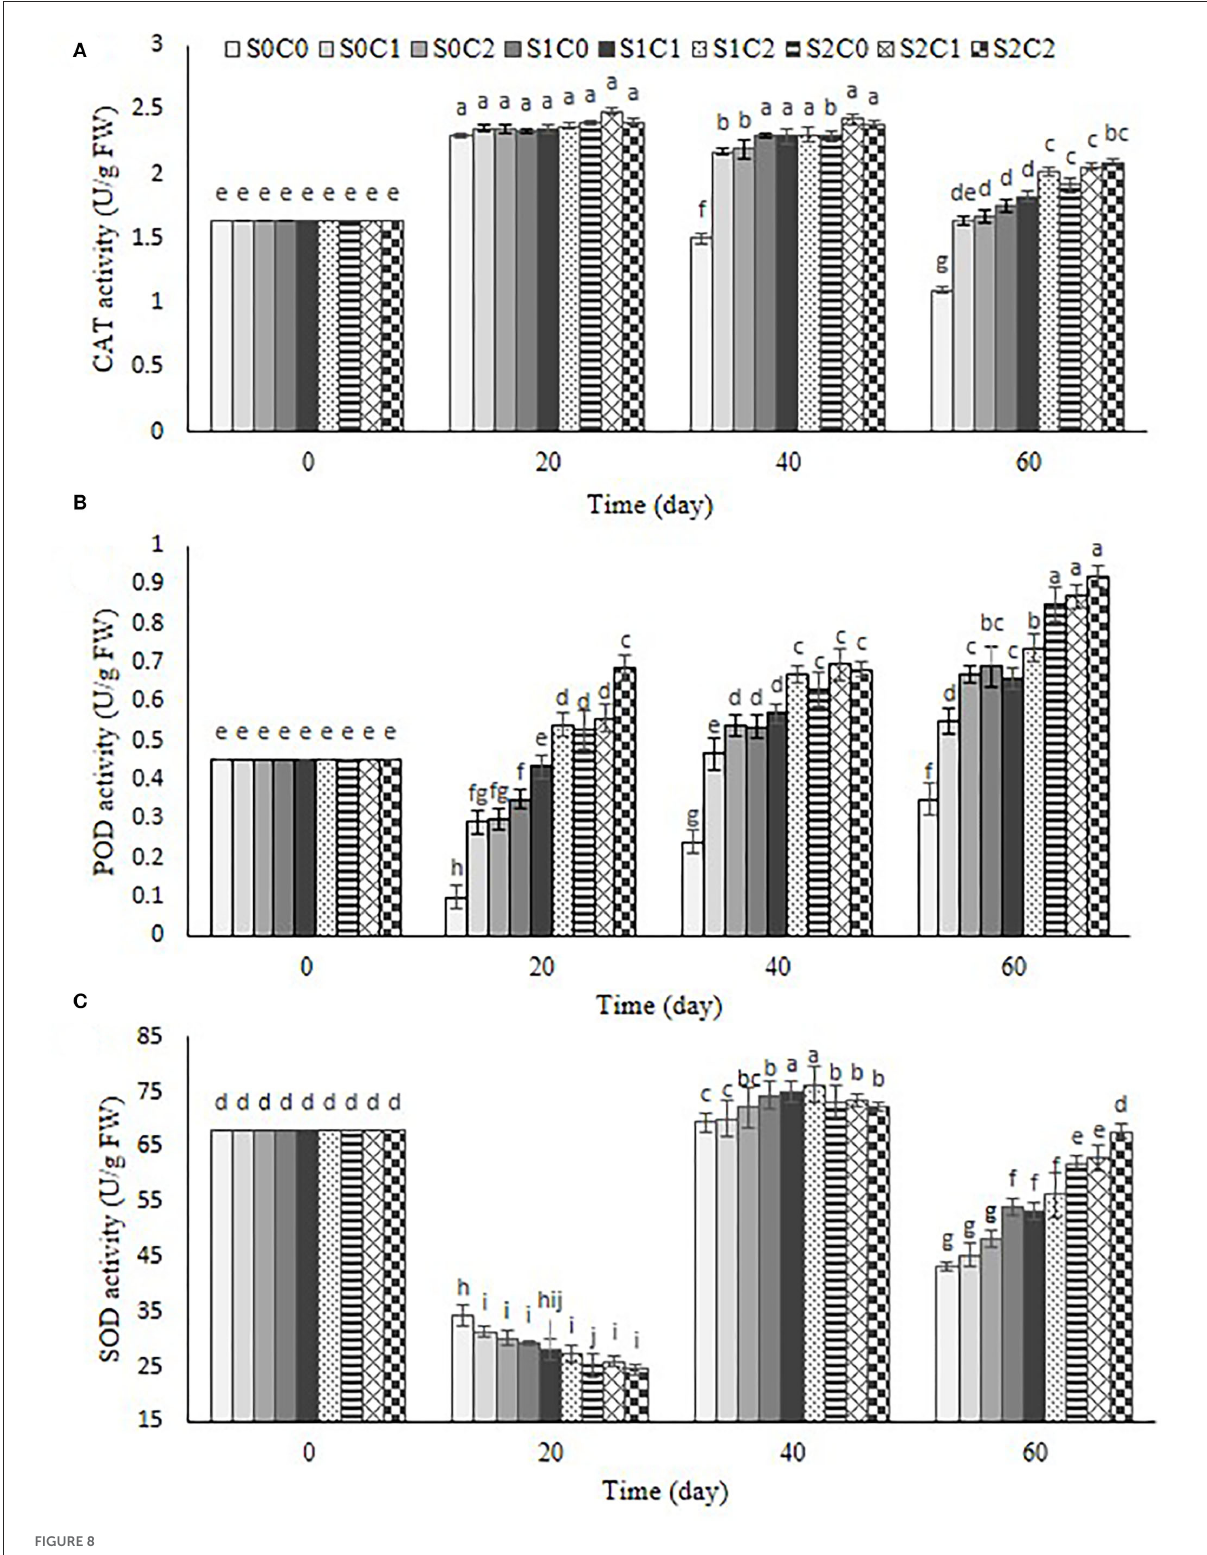
FIGURE8 Effect of foliar spraying of SA and caraway oil coating on CAT (A) , POD (B) , and SOD (C) during 60 d of storage at 4 ± 2 ◦ C plus shelf life (2 d, 20 ◦ C). S0C0: control, S0C1: 0.3% caraway oil, S0C2: 0.6% caraway oil, S1C0: 1.5mM Salicylic acid, S1C1: 1.5mM Salicylic acid + 0.3% caraway oil, S1C2: 1.5mM Salicylic acid + 0.6% caraway oil, S2C0: 3mM Salicylic acid, S2C1: 3mM Salicylic acid + 0.3% caraway oil, S2C2: 3mM Salicylic acid + 0.6% caraway oil. Values represent mean ± SD of three replications. Different letters indicate significant differences at the 5% level according to the Duncan